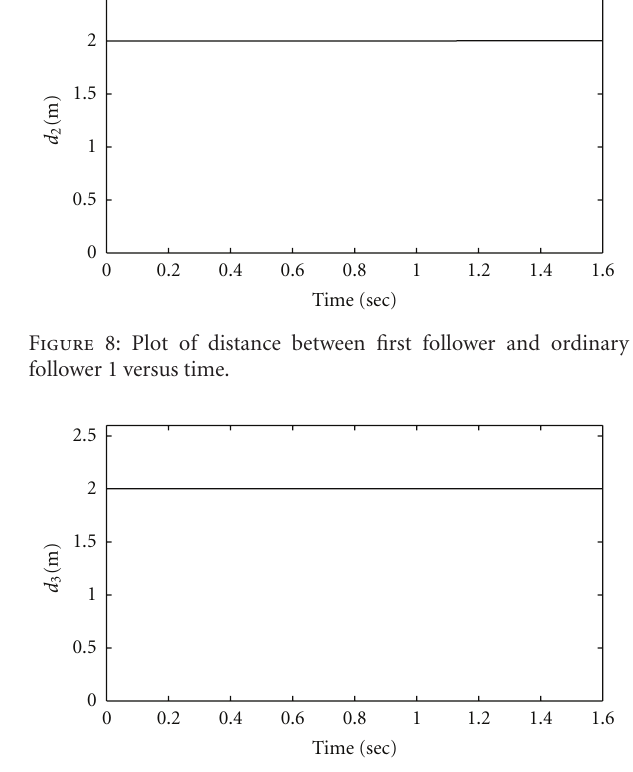
Figure 9: Plot of distance between leader and ordinary follower 1 versus